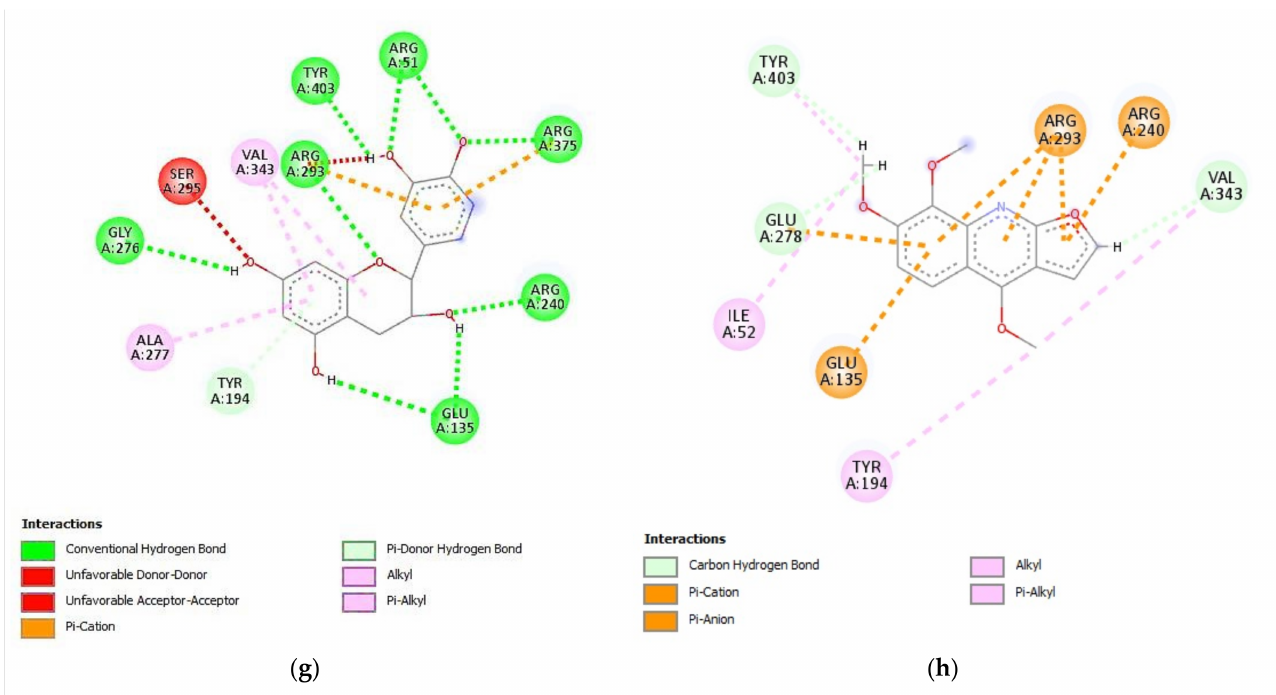
Figure 4. In silico molecular docking results of interactions between HN protein with screened compounds as ligand. ( a ) = Marmelide, ( b ) = Marmenol, ( c ) = Scoparone, ( d ) = Scopoliten, ( e ) = 6 (cid:48) 7 (cid:48) -epoxyaraptene, ( f ) = Quercetin, ( g ) = Catechin, ( h ) =